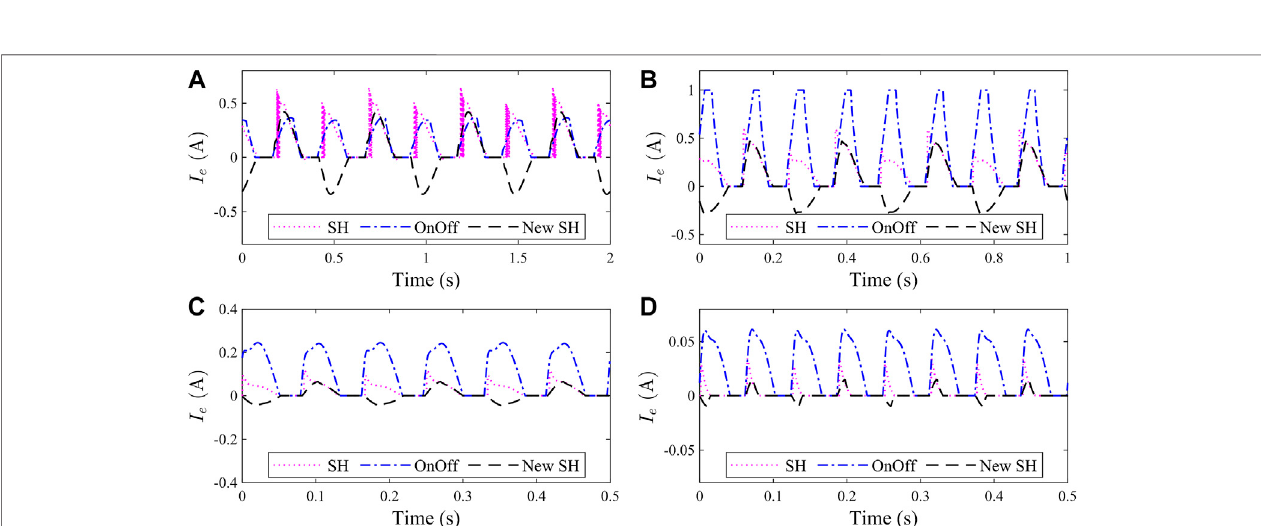
FIGURE 7 | Simulation results of sinusoidal displacement excitation: (A) 2 Hz, (B) 4 Hz, (C) 6 Hz, and (D) 8 Hz.